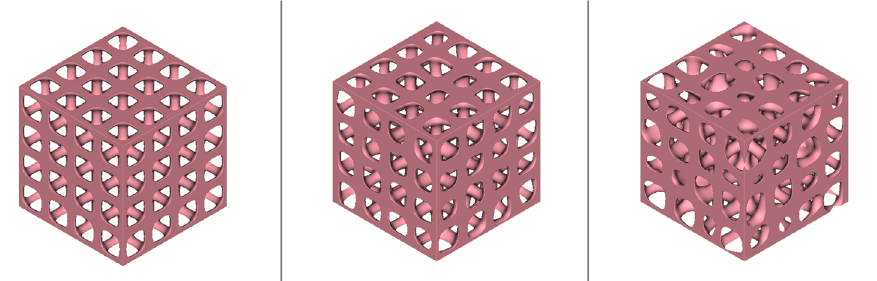
Figure 5. Perturbed shell around a Schwarz-P TPMS structure, from periodic shape ( left ) to increasing aperiodicity ( middle and right ) (authors’ work).